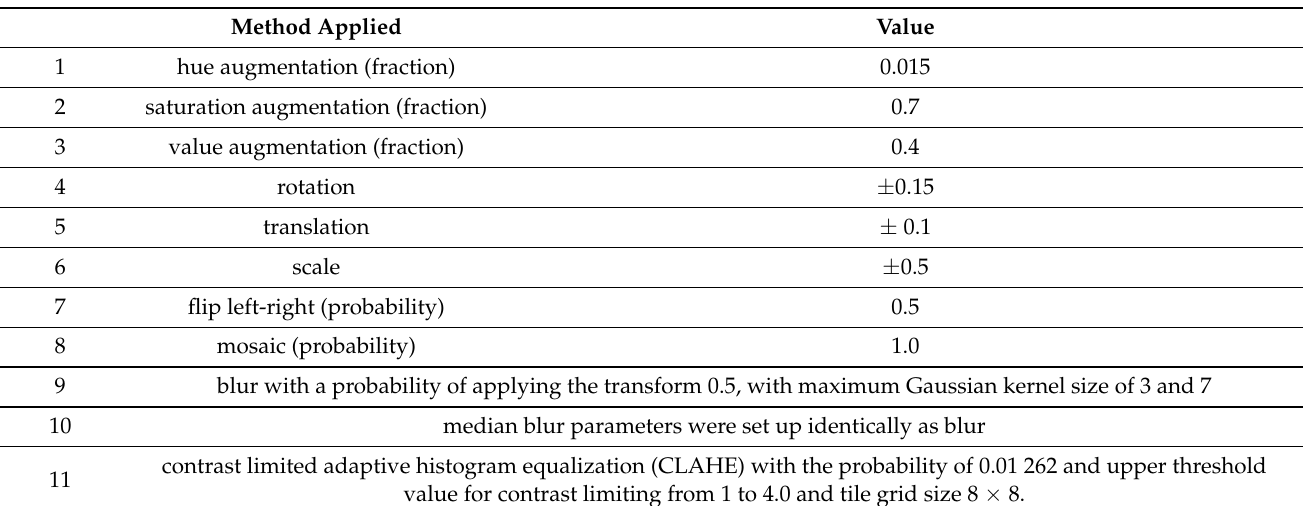
Table 4. Metrics and processes applied to the